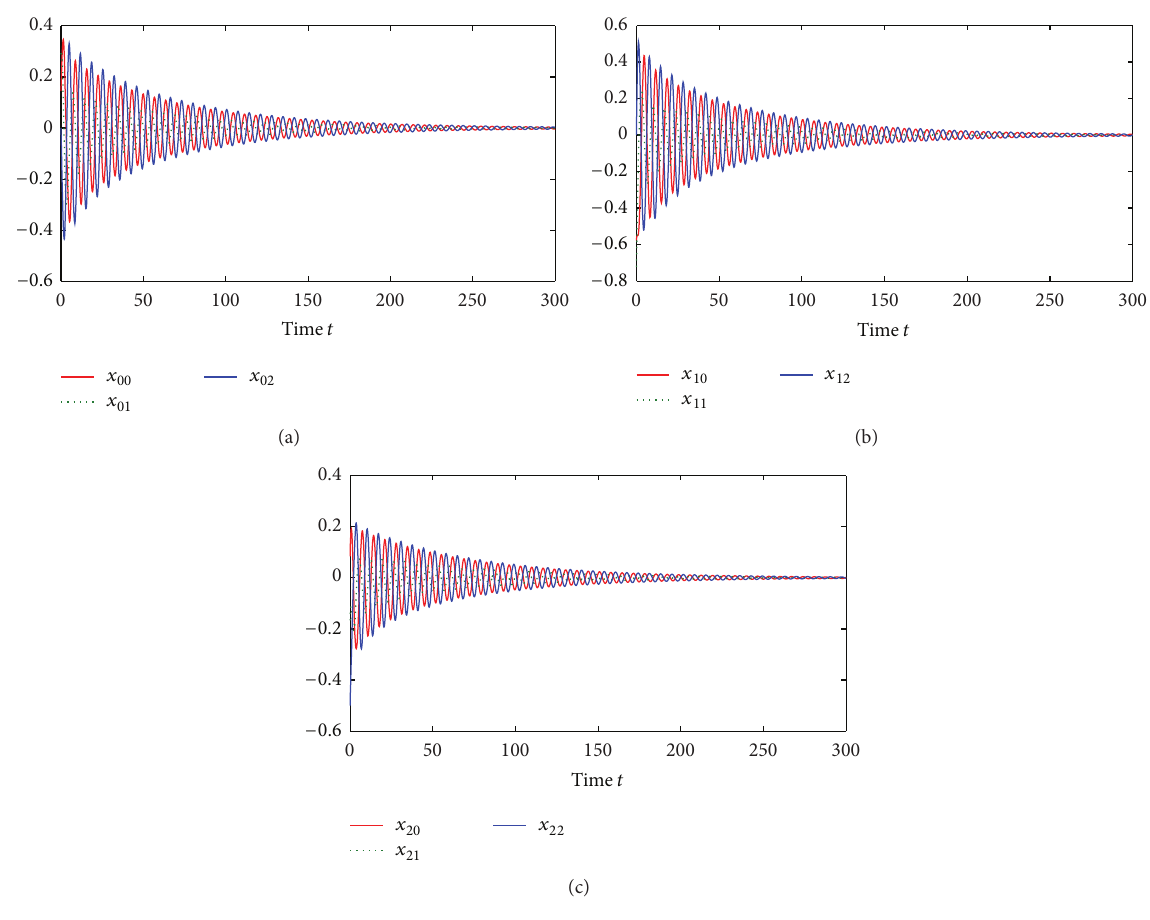
Figure 2: Trajectories 𝑥 𝑖,𝑗 (𝑖,𝑗 = 0,1,2) of system (42) when 𝜏 = 2.6 .